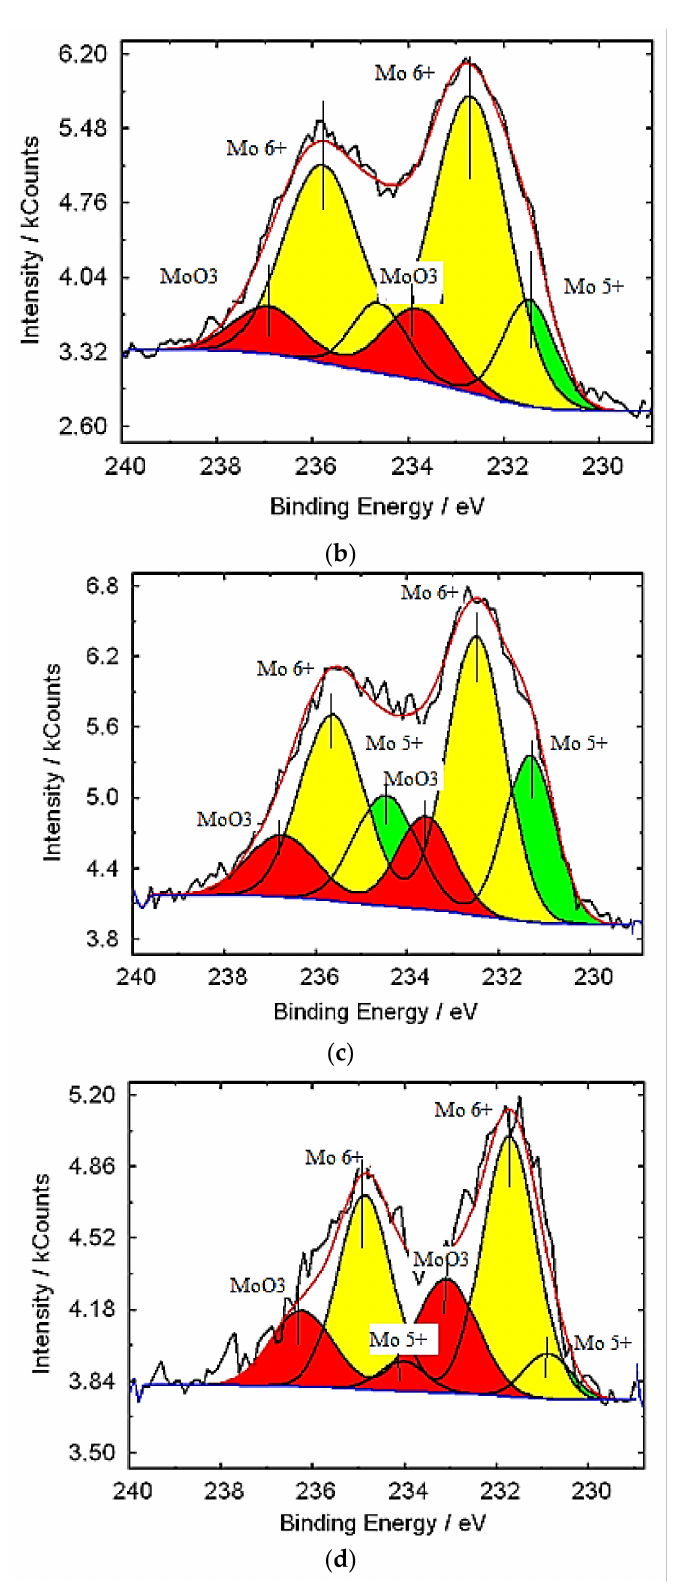
Figure 5. X-ray photoelectron spectroscopy (XPS) spectrum of Mo ( a – d ) in molybdenum–tungsten oxide nanoclusters: (Mo)/(W) = 95/5 ( a ); (Mo)/(W) = 90/10 ( b ); (Mo)/(W) = 80/20 ( c ); and (Mo)/(W) = 50/50 ( d